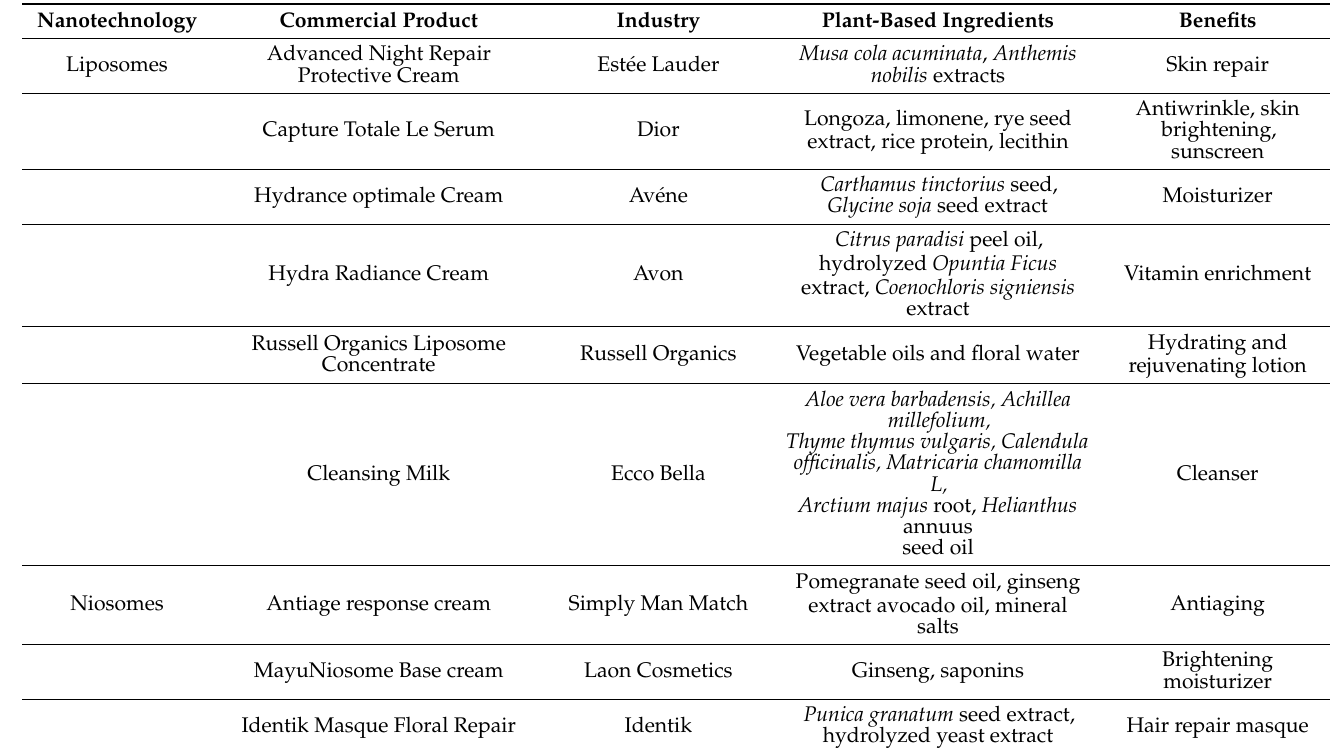
Table 2. Example of commercialized natural nanocosmetics